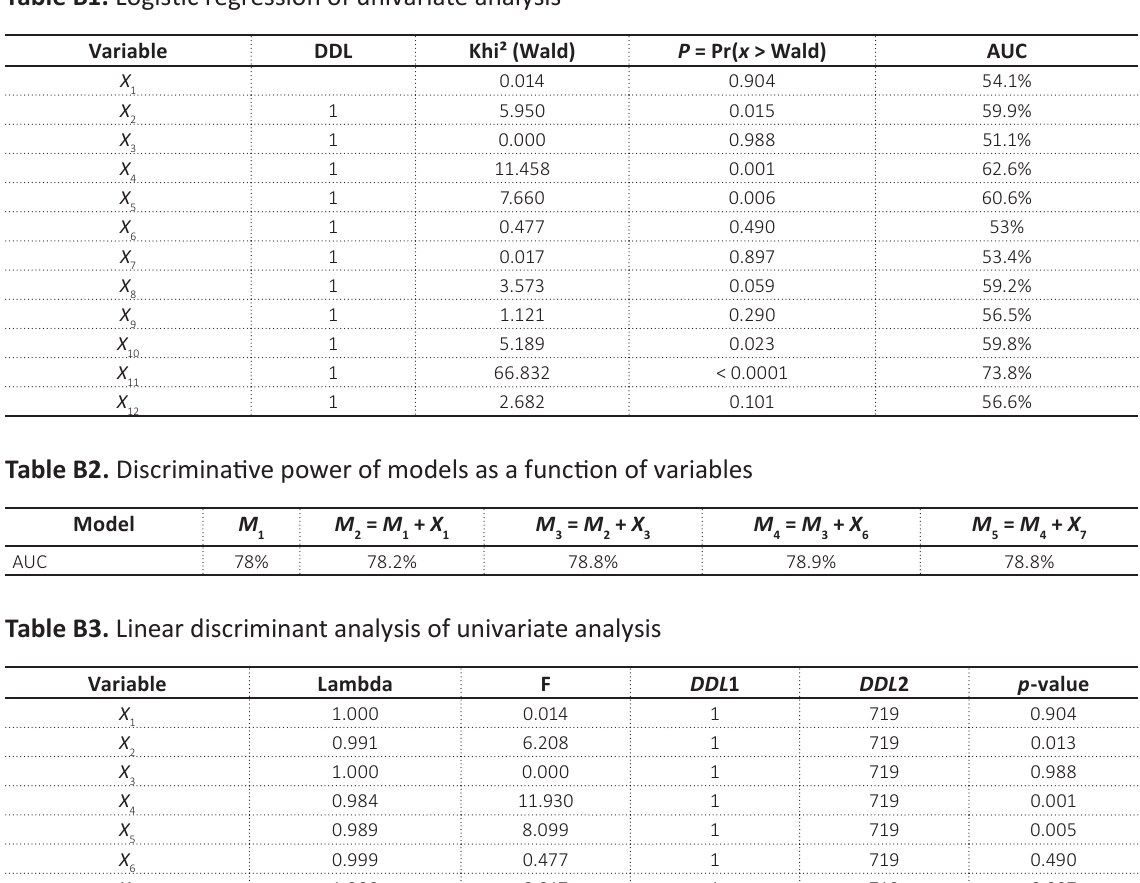
Table B1. Logistic regression of univariate analysis